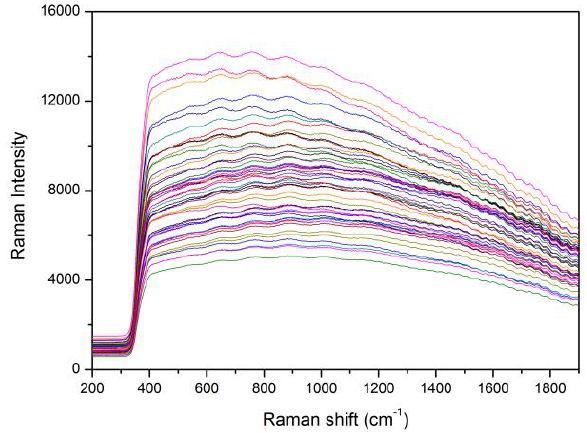
Figure 4. Original Raman spectra of bacteria-infected and healthy watermelon seeds.